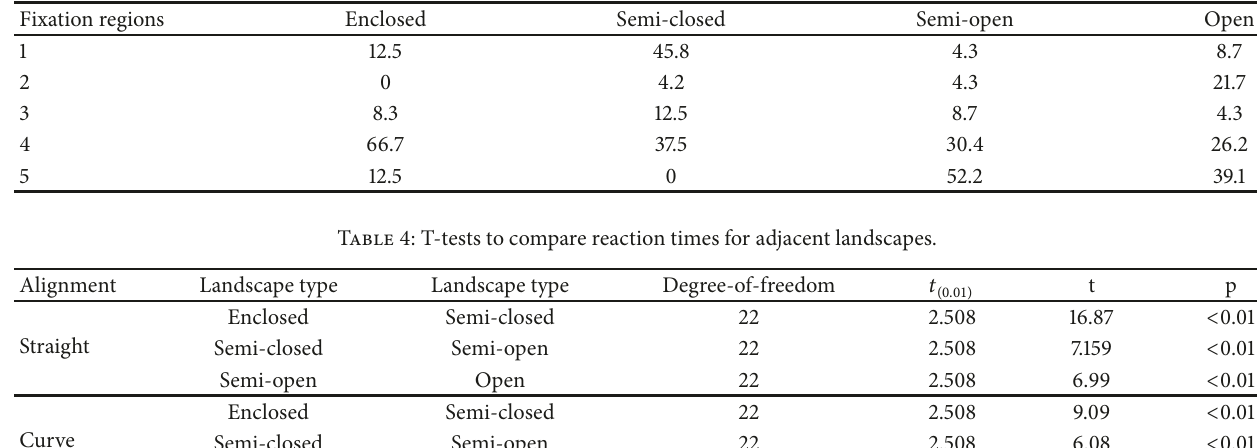
Table 3: Statistics on the percentage of drivers’ visual fixations of each region at the moment when the box was dropped under different highway landscapes.